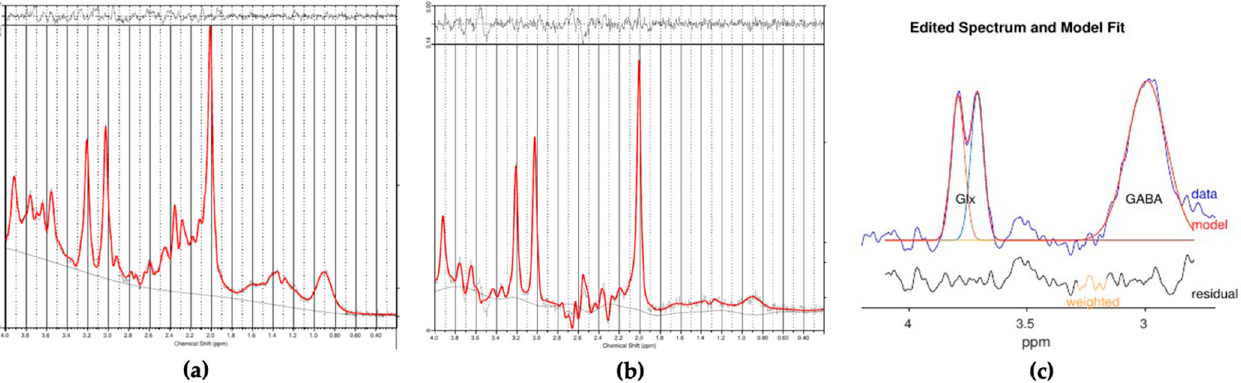
Figure 2. LCModel MRS Spectra from ( a ) PRESS and ( b ) MEGA-PRESS sequence. ( c ) Modeling of GABA signal: GABA- edited spectrum is shown in blue, while the model of best fit is displayed in red. Gannet software uses a simple Gaussian model by default. The black lines demonstrate the residual between the blue and red lines.